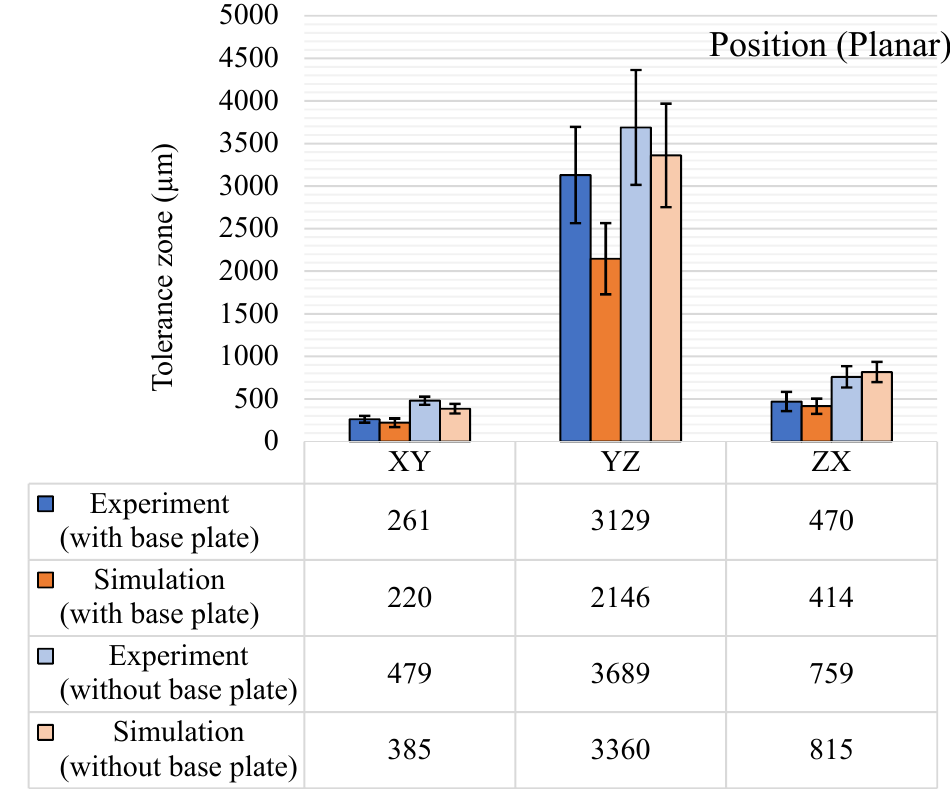
Figure 17. Position tolerance (planar) results (µm), with and without the base plate.